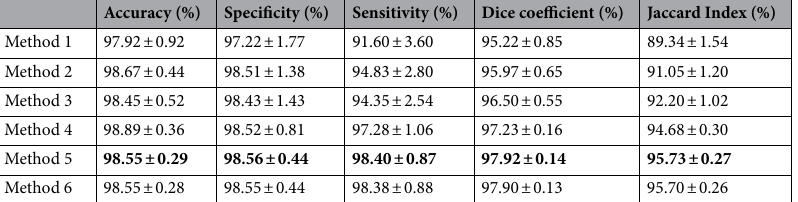
Table 1. Lung segmentation results on the JSRT dataset (mean ± standard deviation). Significant values are in bold.